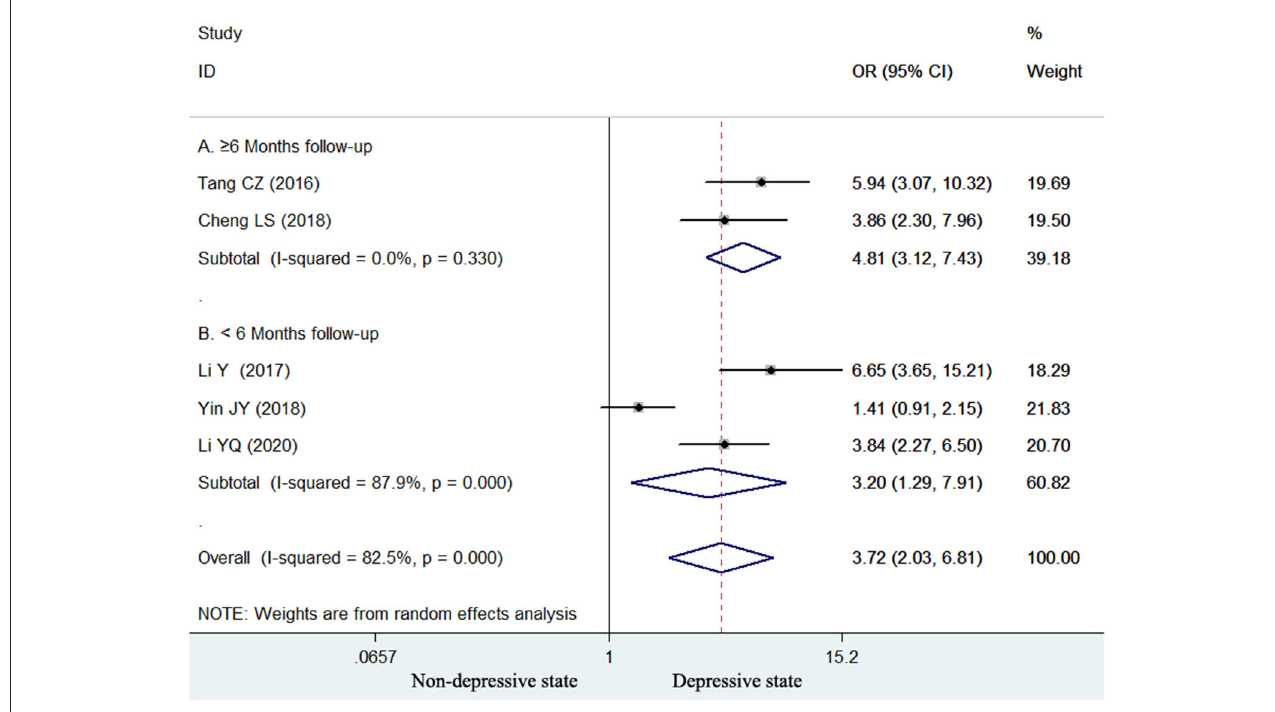
FIGURE2 Forest plots showing the pooled OR with 95% CI of poststroke depression for the top vs. bottom homocysteine level in a random effect model.